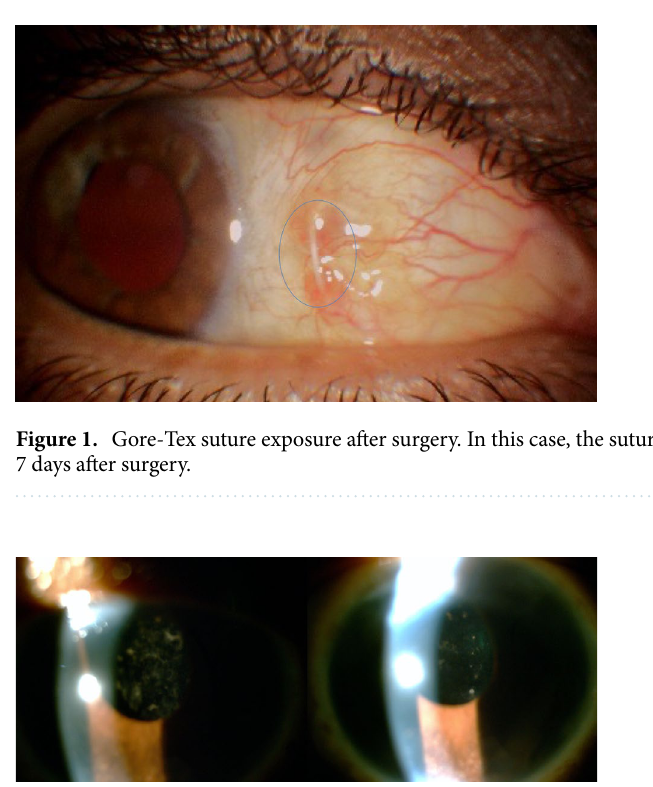
Figure 2. ( a ) Akreos intraocular lens opacification four months after surgery; ( b ) Improvement in lens opacification two months after treatment with topical corticosteroids. The patient had a history of recurrent anterior idiopathic